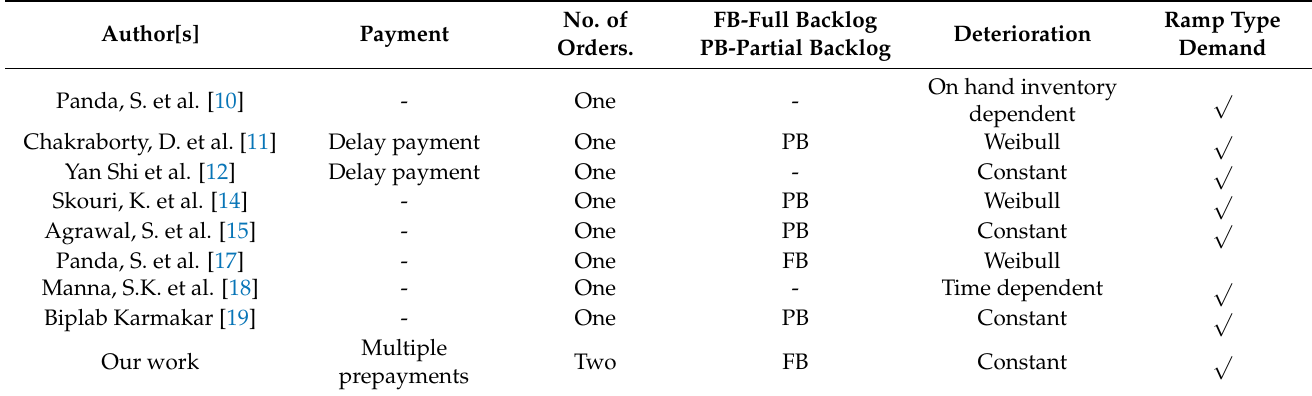
Table 1. Comparison of our model with existing ramp-type demand models in our literature